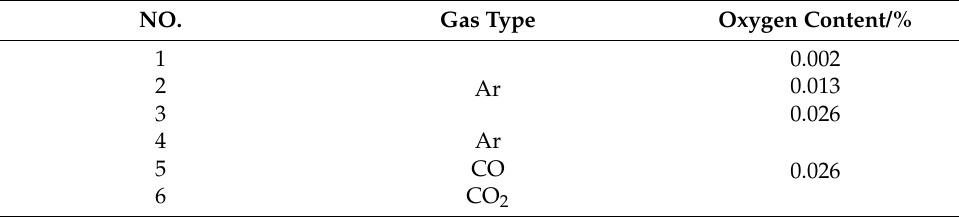
Table 4. Experimental plan for rapid heating